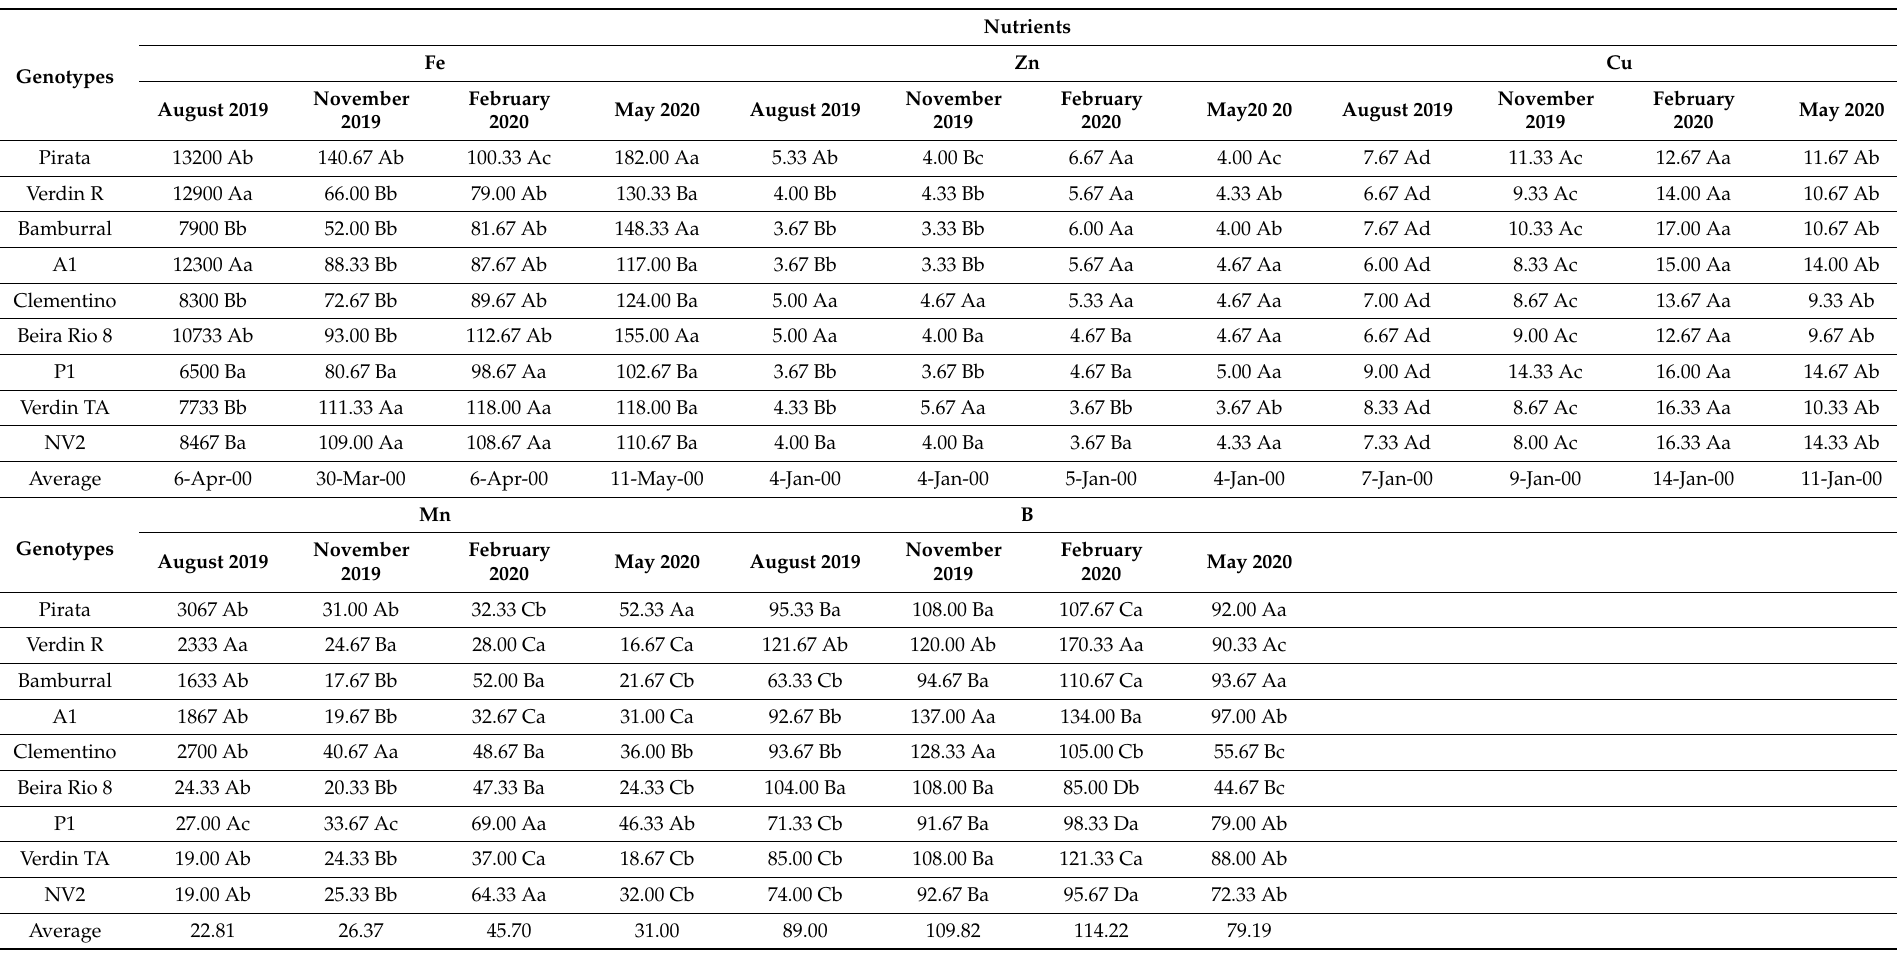
Table 4. Leaf concentration of Fe, Zn, Cu, Mn, and B (mg kg − 1 ) in nine Coffea canephora genotypes for four seasons. S ã o Mateus, state of Esp í rito Santo—Brazil.